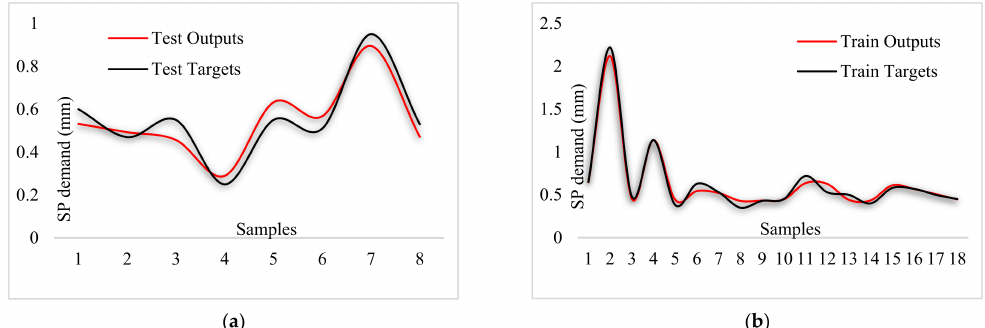
Figure 15. Comparison of outputs and targets for ANFIS-PSO: ( a ) Testing phase, ( b ) training